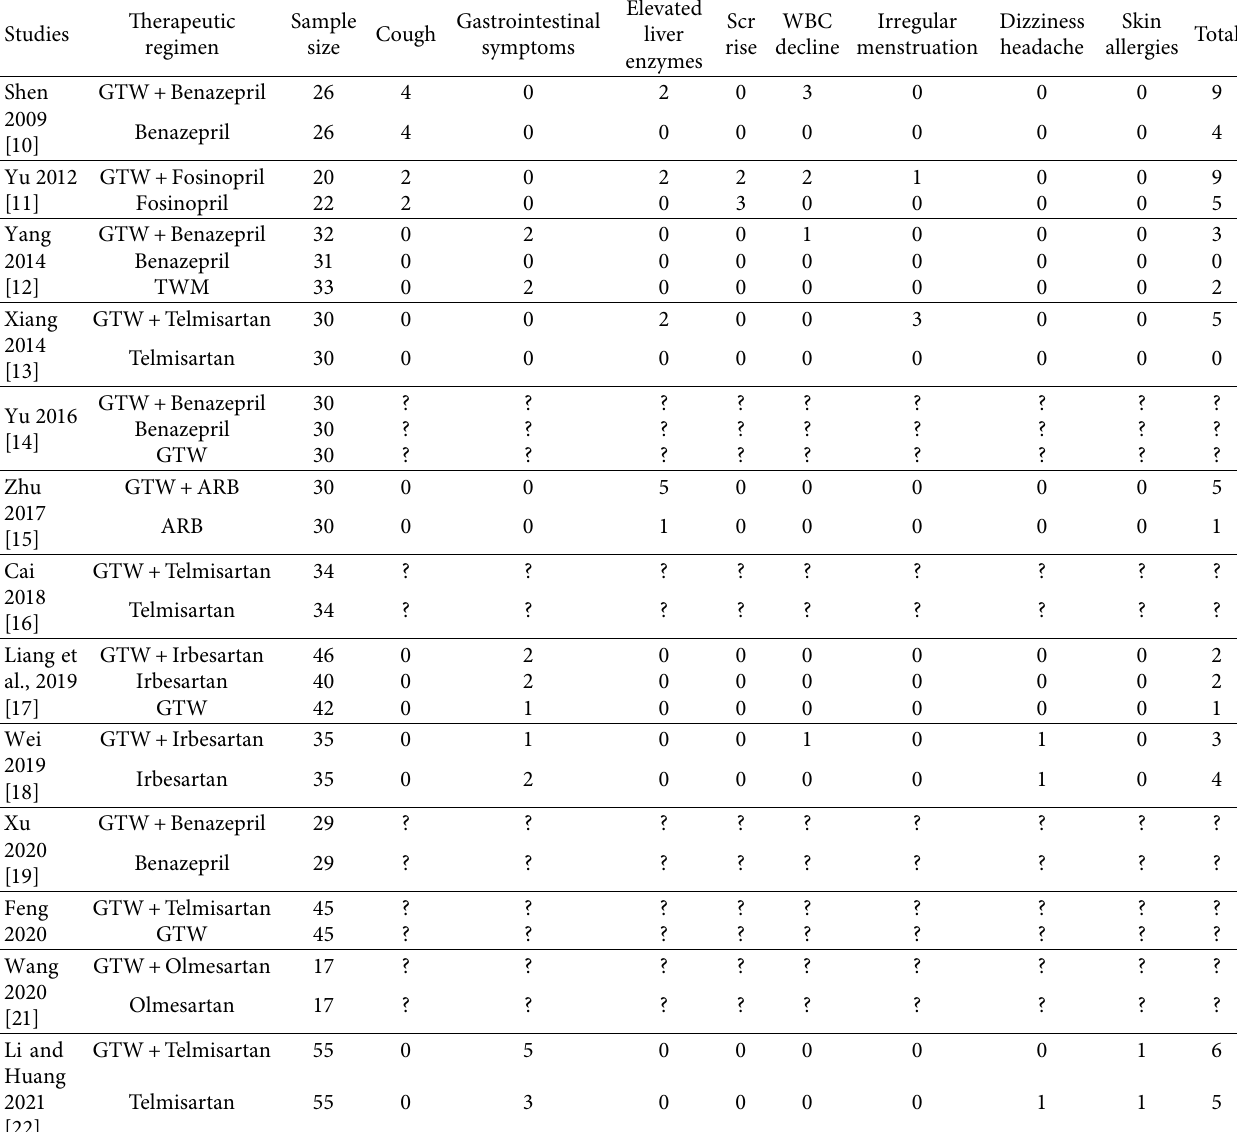
Table 3: Reports of adverse events included in the